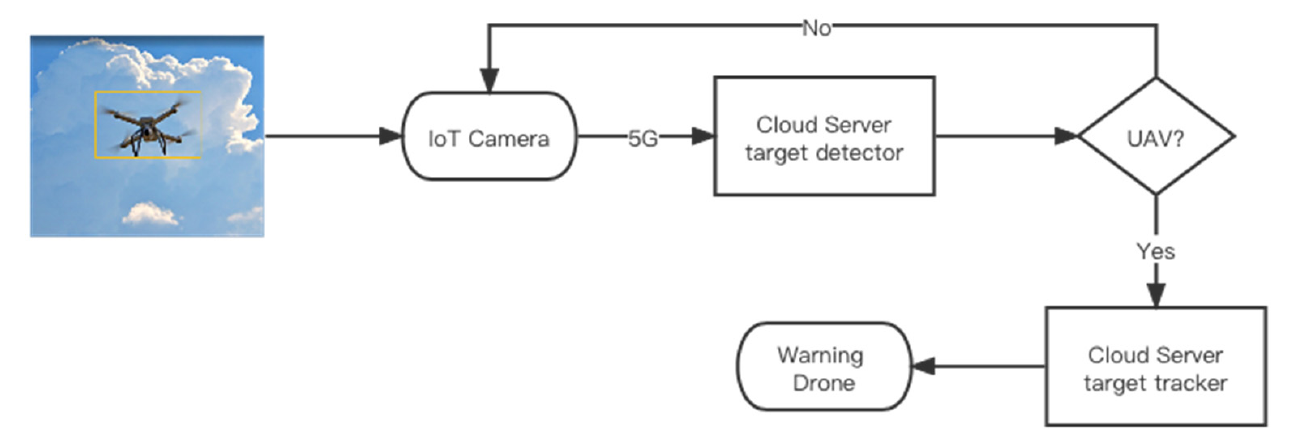
Figure 1. The UAV tracking flow chart.